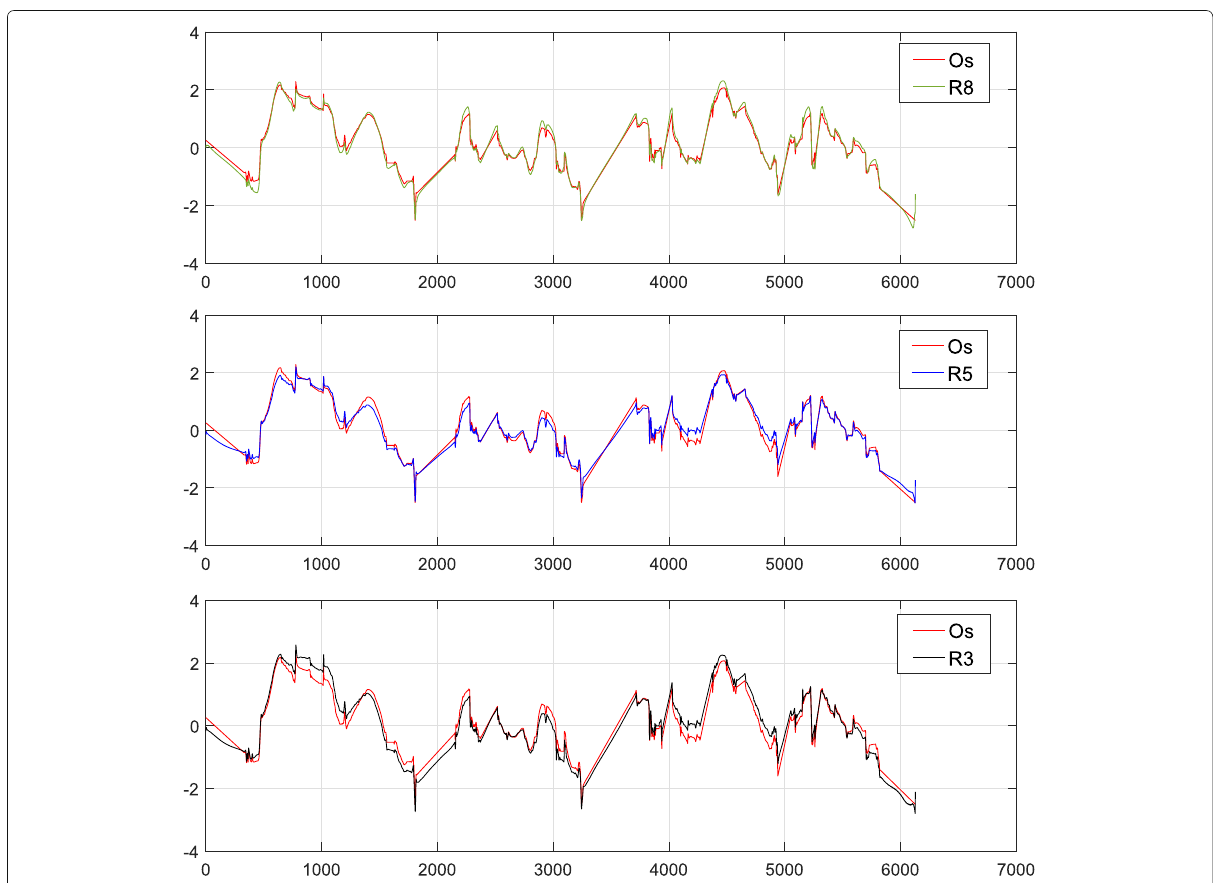
Fig. 8 Examples of original F0 signal and F0 signal reconstructed with different numbers of scales. The topgraph shows the original F0 signal (Os) and the F0 signal reconstructed with eight scales in each temporal level (R8 has 8 × 5 scales in total); the secondgraph shows Os and the reconstructed signal with five scales in each temporal level (R5 has 5 × 5 scales in total); the bottompan shows Os and reconstructed signal